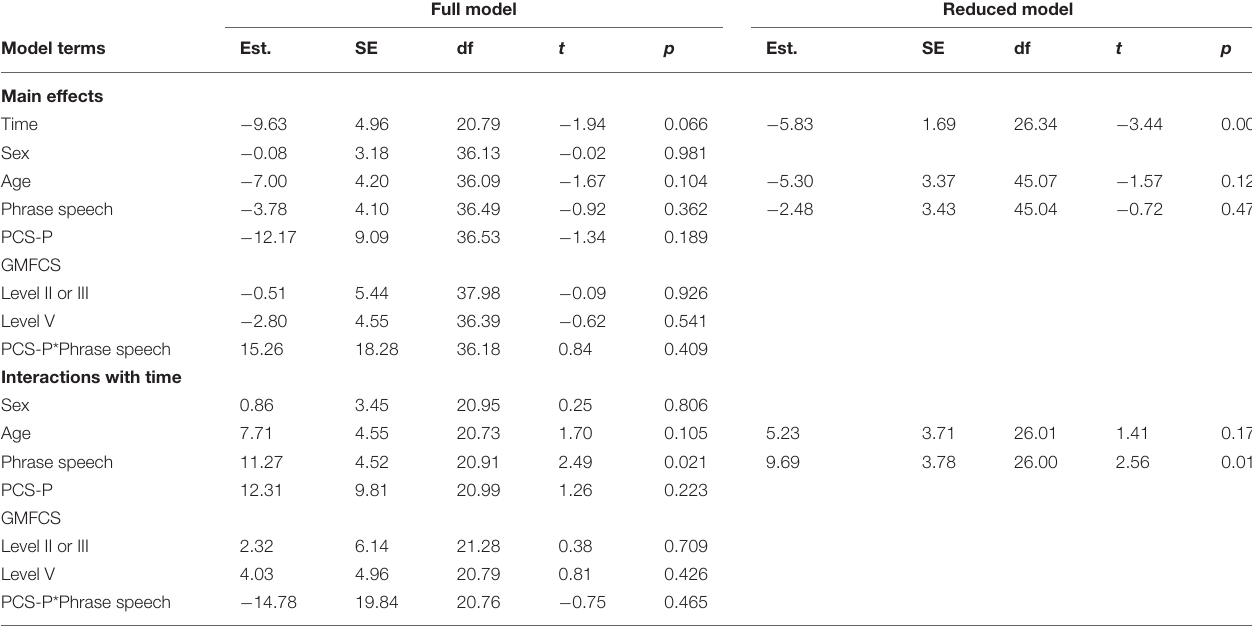
TABLE 5 | Full and reduced linear mixed model results for behavioral reactivity scores.